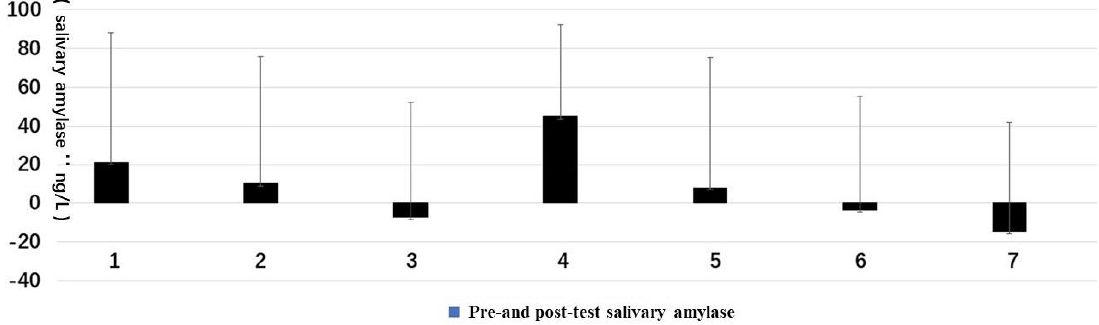
Figure 7. The mean of the ∆ D of salivary amylase: ( 1 ) structure, ( 2 ) wood, ( 3 ) wood with bench, ( 4 ) wood with platform and bench, ( 5 ) platform with trees, ( 6 ) waterfall with trees, and ( 7 ) pool with plants.